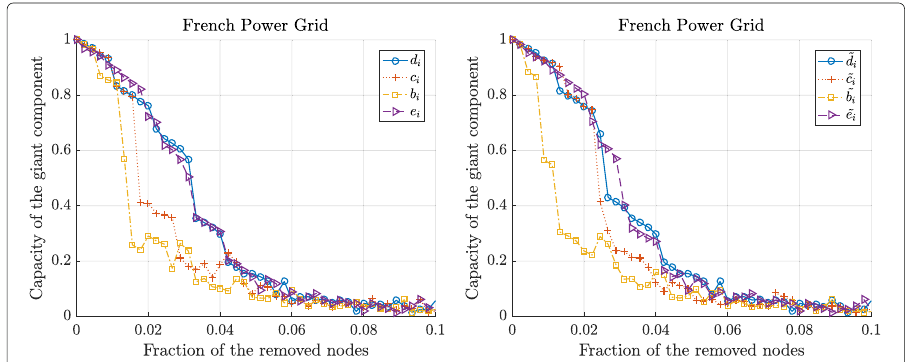
Fig. 4 The normalized capacity of the giant components in the French power grid versus the removal of nodes according to the standard centrality metrics (left) and the extended centrality metrics (right). The node with optimal graph metric, computed in resulting giant component, is removed